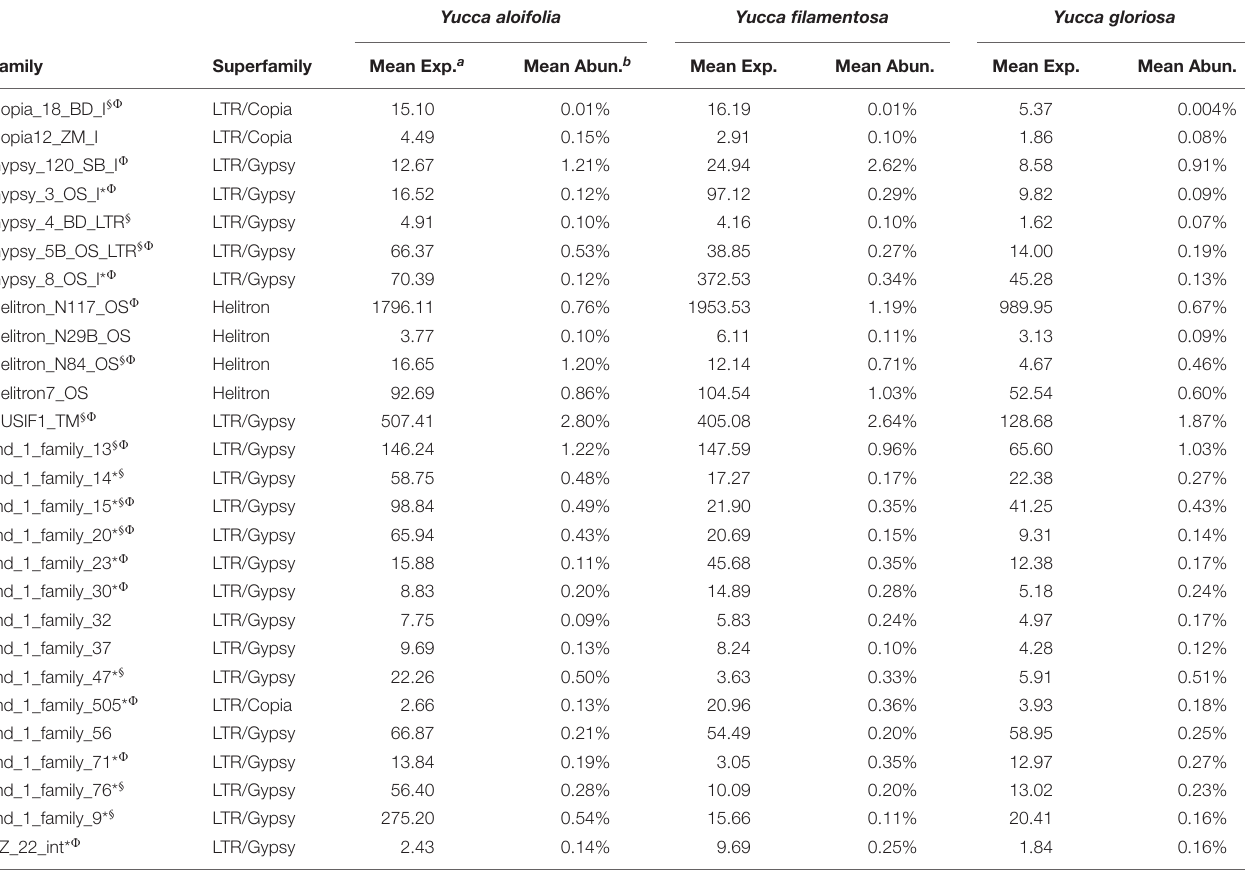
TABLE 1 | Mean expression and abundance of repeat families in Y. aloifolia and Y. filamentosa significantly expressed above zero ( p <